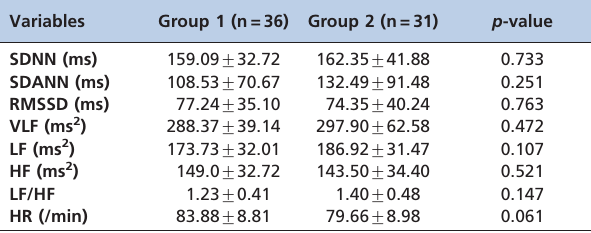
Table 2 - Time and frequency domain parameters of the two groups.